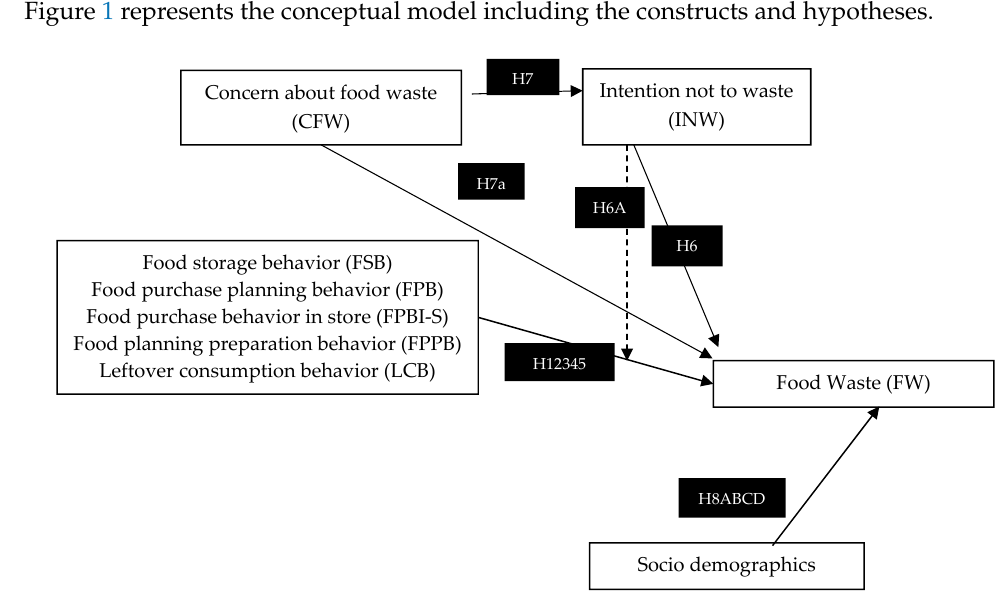
Figure 1. Conceptual model of Dutch households’ reported food waste.